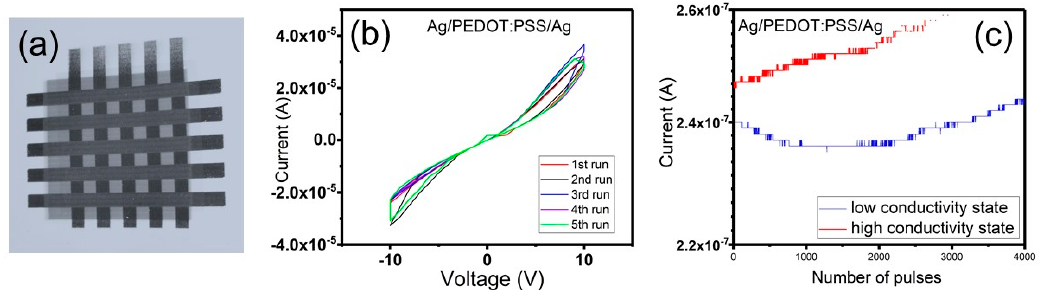
Figure 9. ( a ) Optical microscopy image of the printed crossbar memory cells. ( b ) I–V characteristics of five consecutive runs of the Ag / PEDOT:PSS / Ag memory elements. ( c ) The memory retention time of the printed cells.